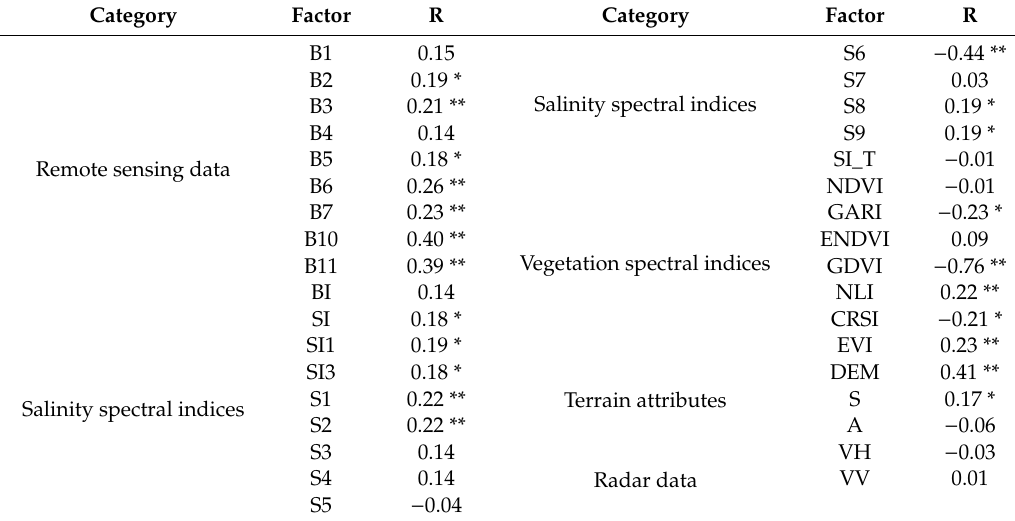
Table 5. Correlation coe ffi cients between 35 indices and measured EC values.